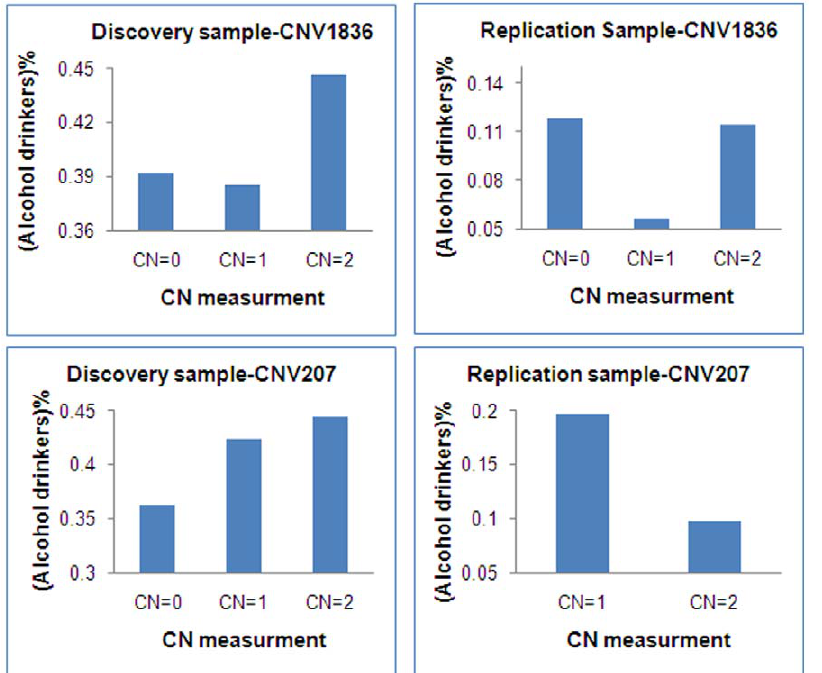
Figure 1. Percentage of alcohol drinkers in groups with different copy number (CN) of CNV207 and CNV1836 in the discovery and replication samples.